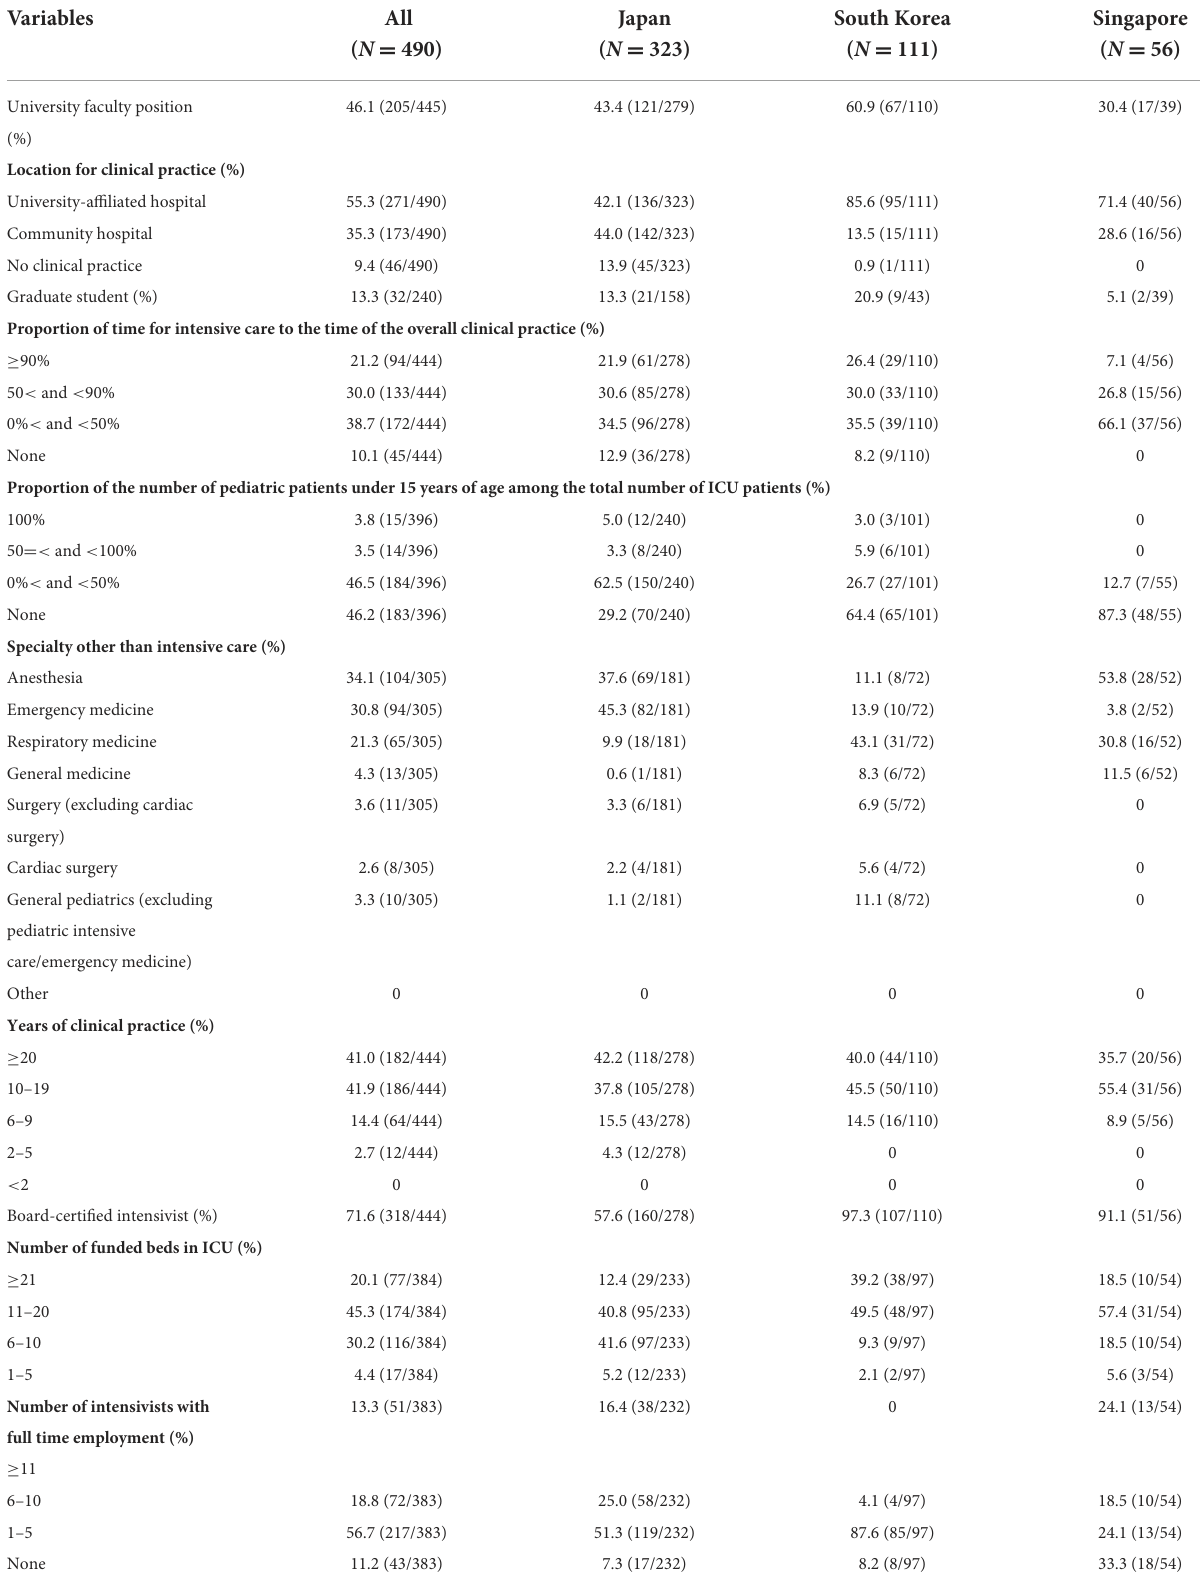
TABLE 1 Demographic characteristics of the respondents and their